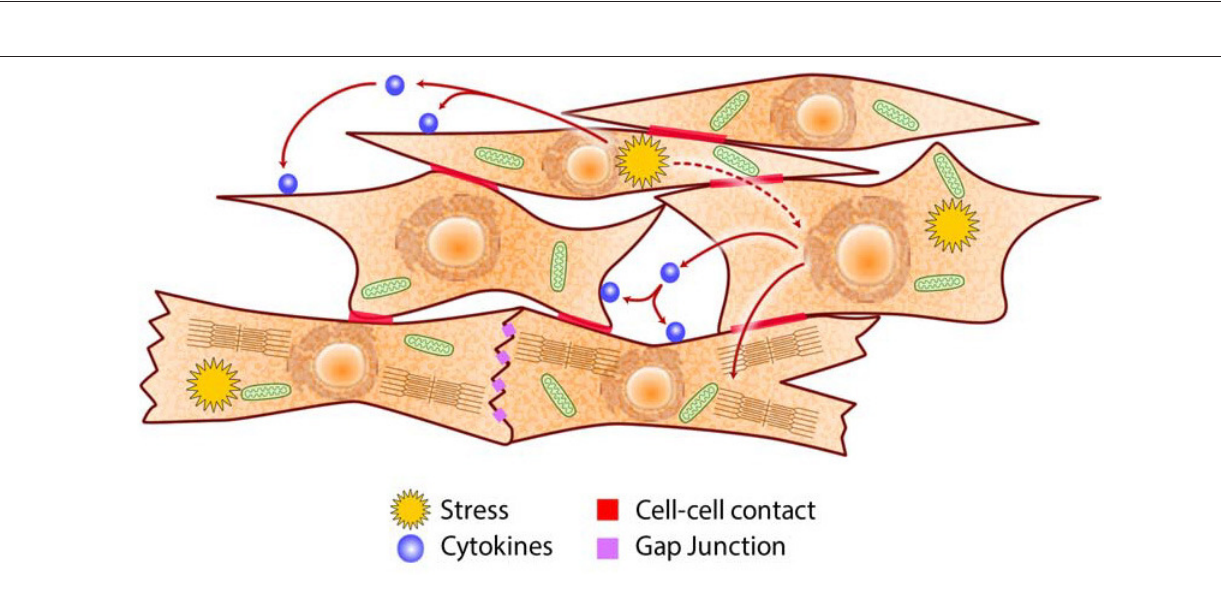
FIGURE 4 | Schematic of intercellular communications in the heart. Cardiac cells communicate via cell-cell contacts (e.g., adhesion molecules, gap junctions), paracrine/autocrine signaling (e.g., cytokines, growth factors), and metabolites (e.g., ROS, adenosine, NO) to coordinate their specific roles in generating the heartbeat and in adapting to metabolic